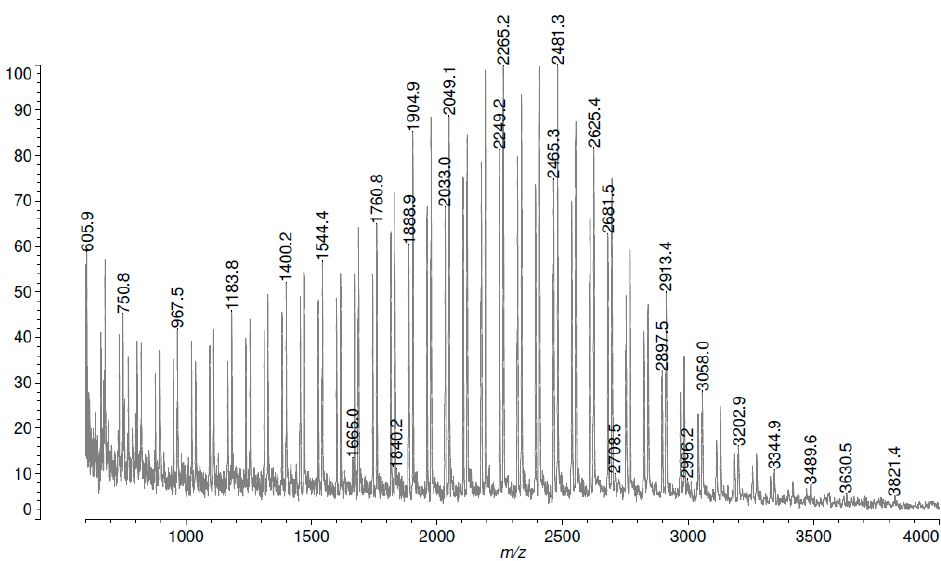
Figure 4. MALDI-TOF spectrum of PPO-diol (1) obtained with K-DPG/L.